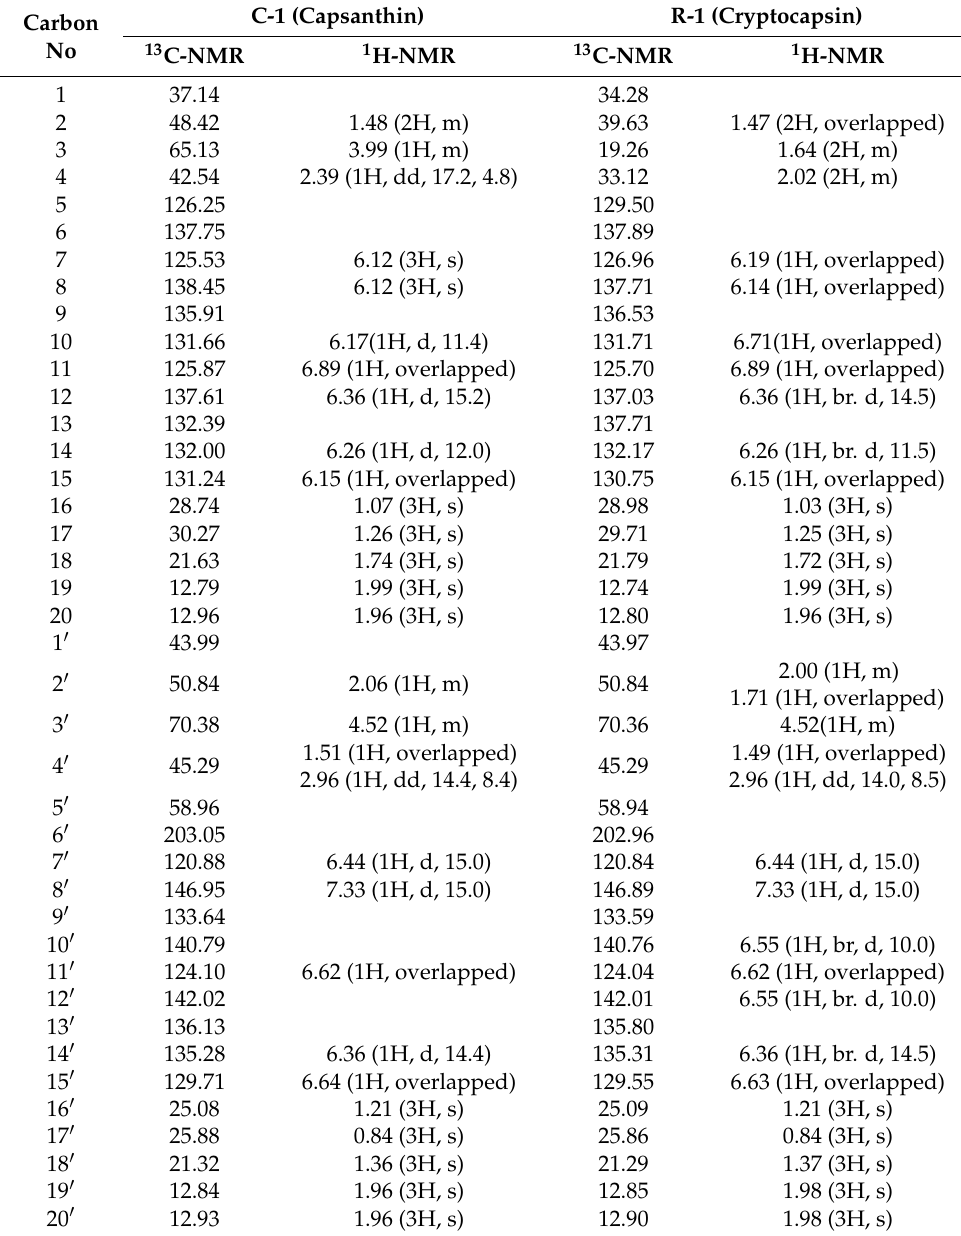
Table 1. NMR spectral data for compounds C-1 and R-1 a .